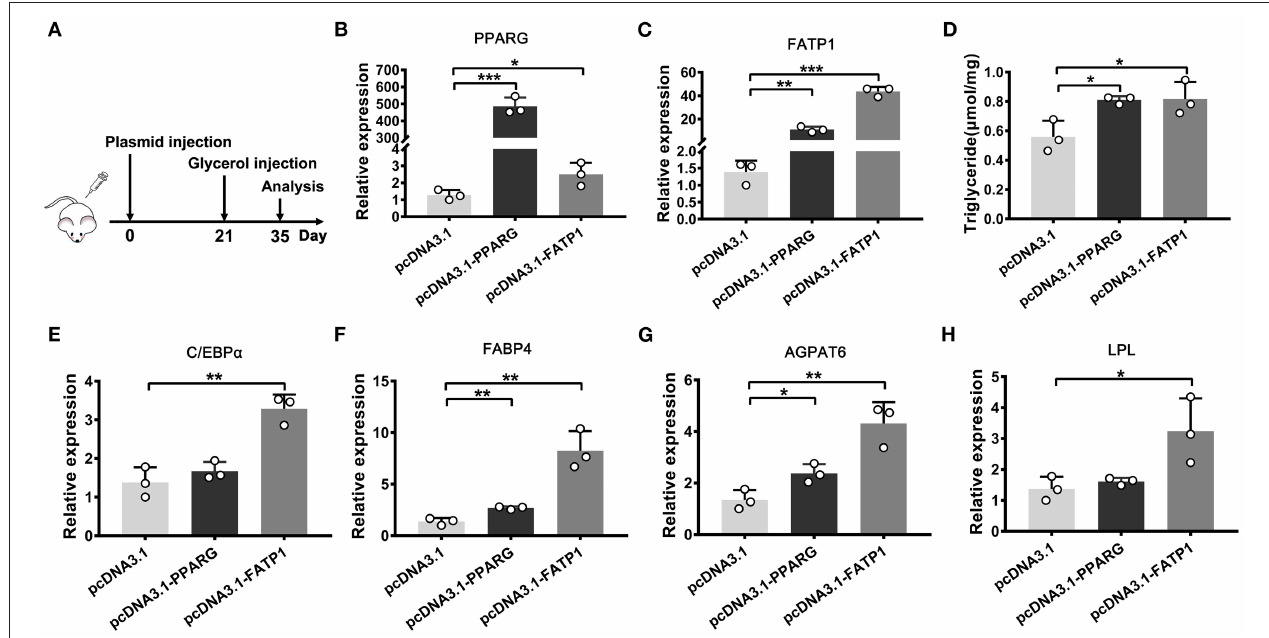
FIGURE 8 | The overexpression of FATP1 increases the intramuscular fat content in the mouse. (A) The strategy employed for intramuscular plasmid injection. The expression of PPARG (B) , FATP1 (C) , CEBPA (E) , FABP4 (F), AGPAT6 (G) , and LPL (H,D) triglyceride levels in the gastrocnemius muscle injected with the indicated plasmid 2 weeks after glycerol injection. Data are presented as means ± SD, * p < 0.05, ** p < 0.01, *** p <